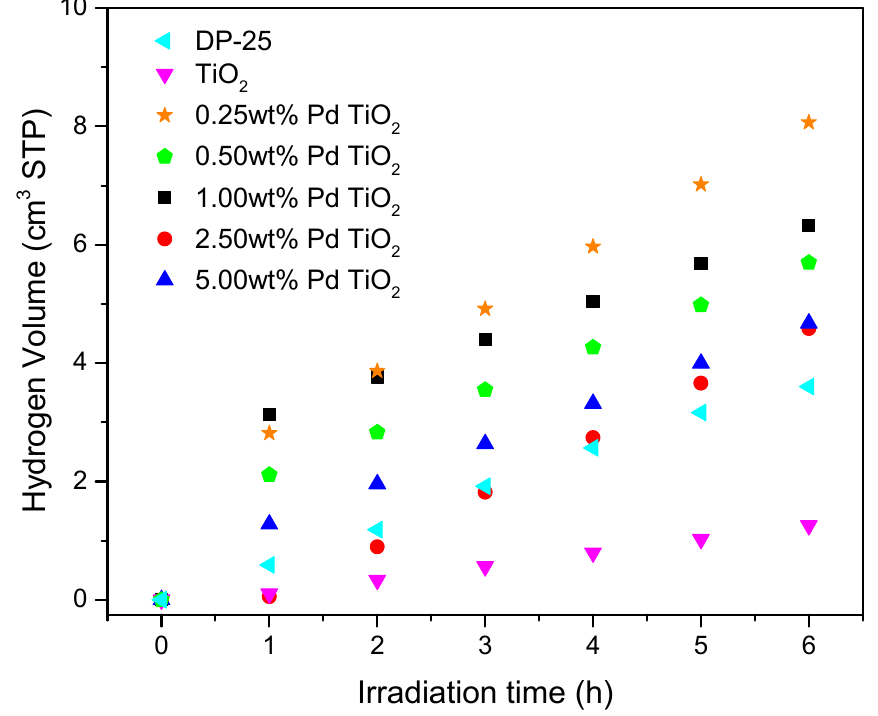
Figure 9. Cumulative Hydrogen Volume at Di ff erent 0.25, 0.50, 1.00, 2.50 and 5.00 wt% Pd Loadings utilizingaphotoreducedphotocatalystafterUVlightexposure. Conditions: Photocatalystconcentration: 0.15g / L, 2.0 v / v % ethanol, pH = 4 ± 0.05. Experimental data is the result of 4 consecutive runs for each